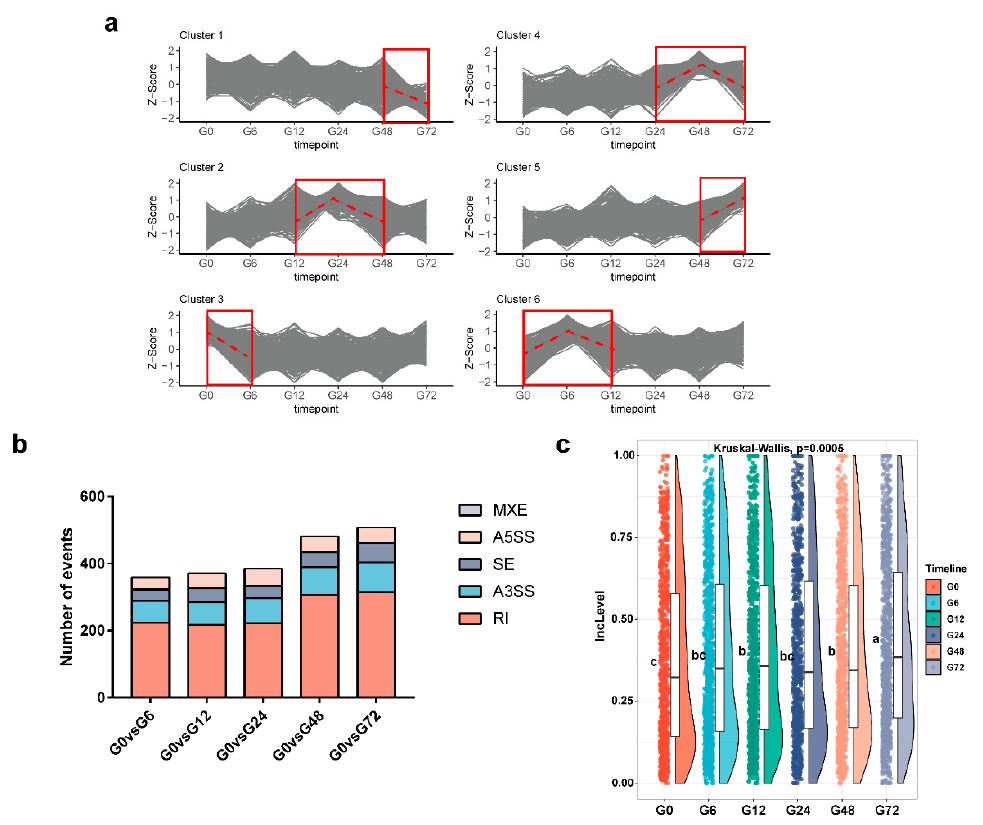
Figure 3. Analysis of di ff erential alternative splicing events (DSEs). ( a ) Clustering analysis of DSEs according to standardized IncLevels (Z-scores). Red boxes and dotted lines show dynamic changes of Z-scores in six clusters. ( b ) Numbers of DSEs identified over the time course. ( c ) General IncLevel value changes of di ff erential alternative splicing RI events in time order. Kruskal-Wallis method was used to represent the levels of significance. Dunn’s test was used for multiple comparisons. The “a”, “b”, “c” and “d” represent significant levels.